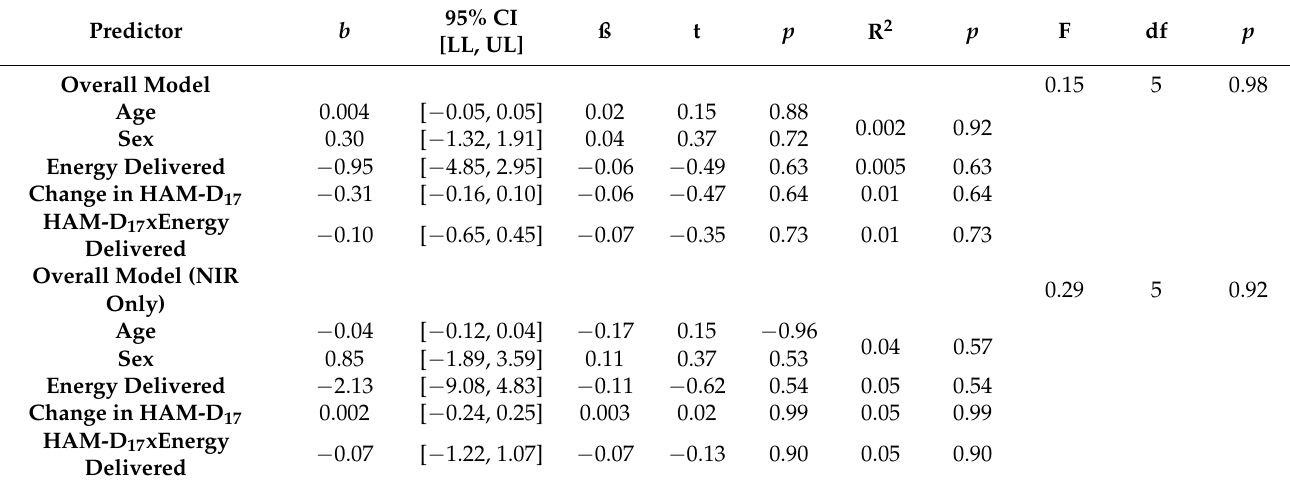
Table 3. Hierarchical regressions predict the number of adverse events